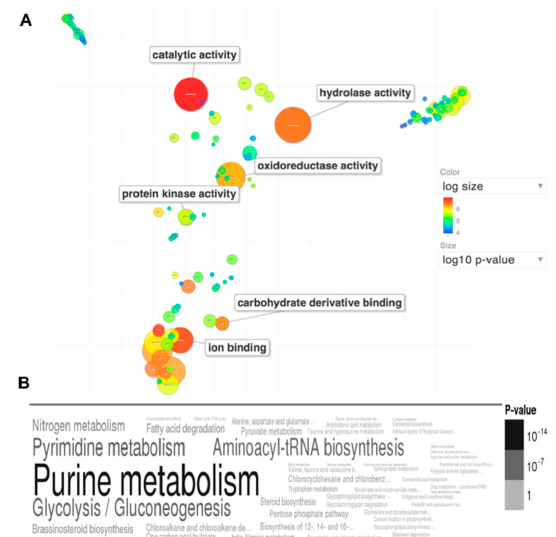
Figure 3. Gene ontology enrichment analysis of the 27 biomarker candidates indicates enriched hydrolase activity and increased purine and carbohydrate metabolism functions. ( A ) Scatterplot of gene ontology enrichment of molecular functions, with size of the circles is proportional to the significance of enrichment. ( B ) Word cloud of enriched KEGG metabolic pathways. Size of the words indicates significance of enrichment. Figures were produced using the Revigo (Supek and others 2011) and GOSummaries (Kolde and Vilo 2015) wordcloud plugin from FungiDB (www.fungidb.org) (Basenko and others 2018).